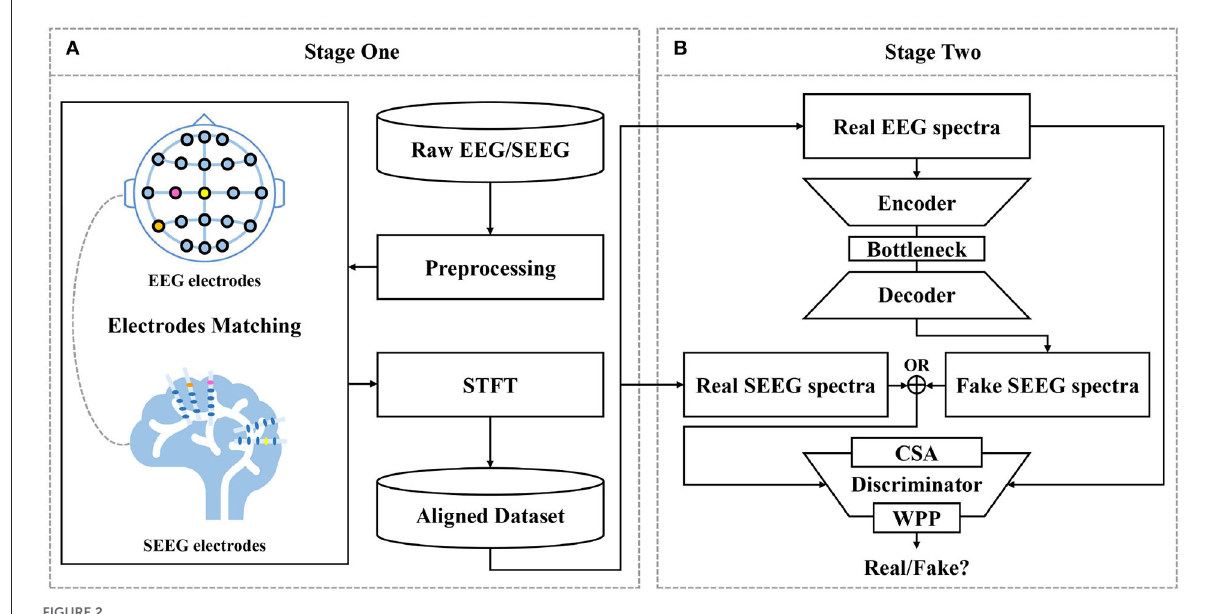
FIGURE2 Proposed framework for EEG-to-SEEG translation. (A) Raw EEG and SEEG signals are filtered and segmented using a synchronized sliding window. Then, segments from two sources are matched into pairs with the proposed strategy. Short-Time Fourier Transform (STFT) is performed to obtain magnitude and IF spectra. The aligned dataset is constructed with the processed pairs. (B) EEG-to-SEEG generative adversarial network (E2SGAN) is trained on the aligned dataset to synthesize SEEG from simultaneous EEG. Correlative Spectral Attention (CSA) and Weighted Patch Prediction (WPP) are devised to give a further boost to the discriminator.